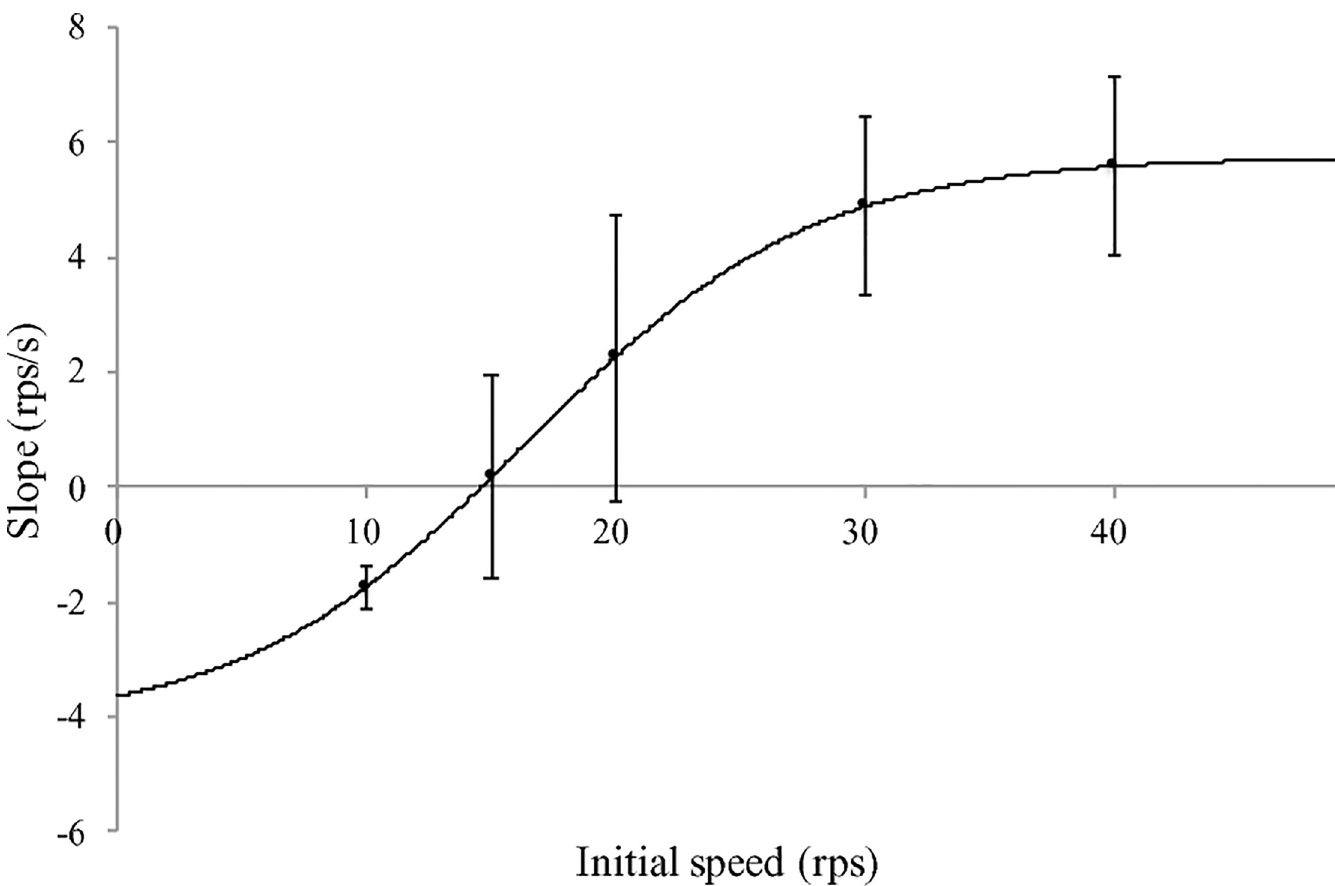
Fig 4. The sigmoid function fit of the average slope over 5 initial speed conditions. The error bars indicate the between participants SD.